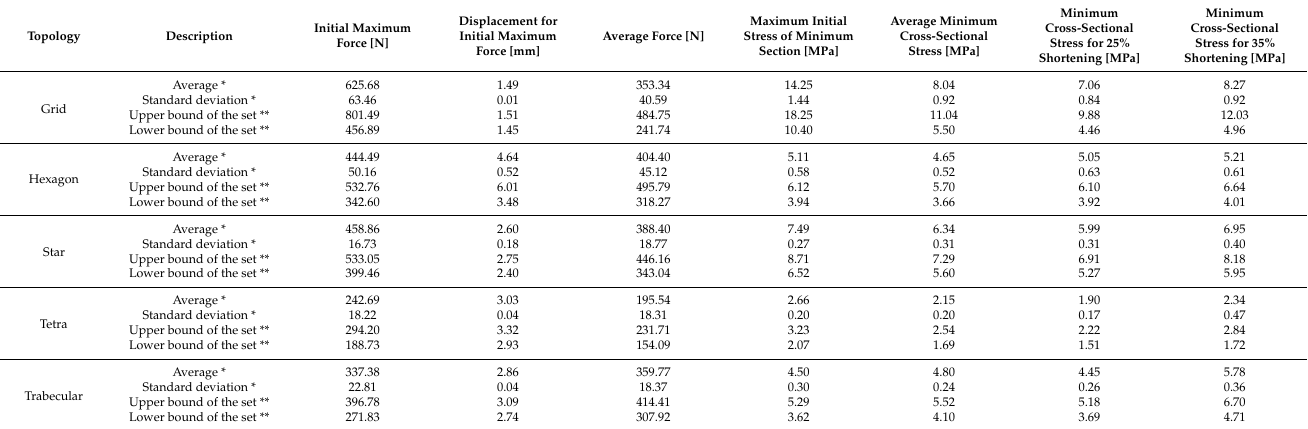
Table 4. Statistical calculations of the analysed parameters for each